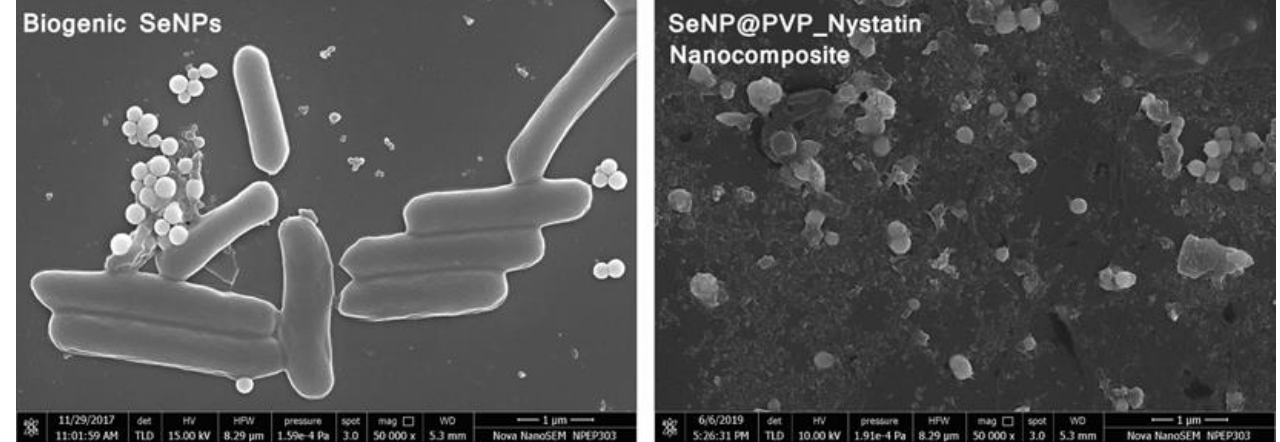
Figure 4. FESEM analysis of Biogenic SeNPs and SeNP@PVP_Nystatin nanoconjugates. Biogenic SeNPs are shown along with cells.